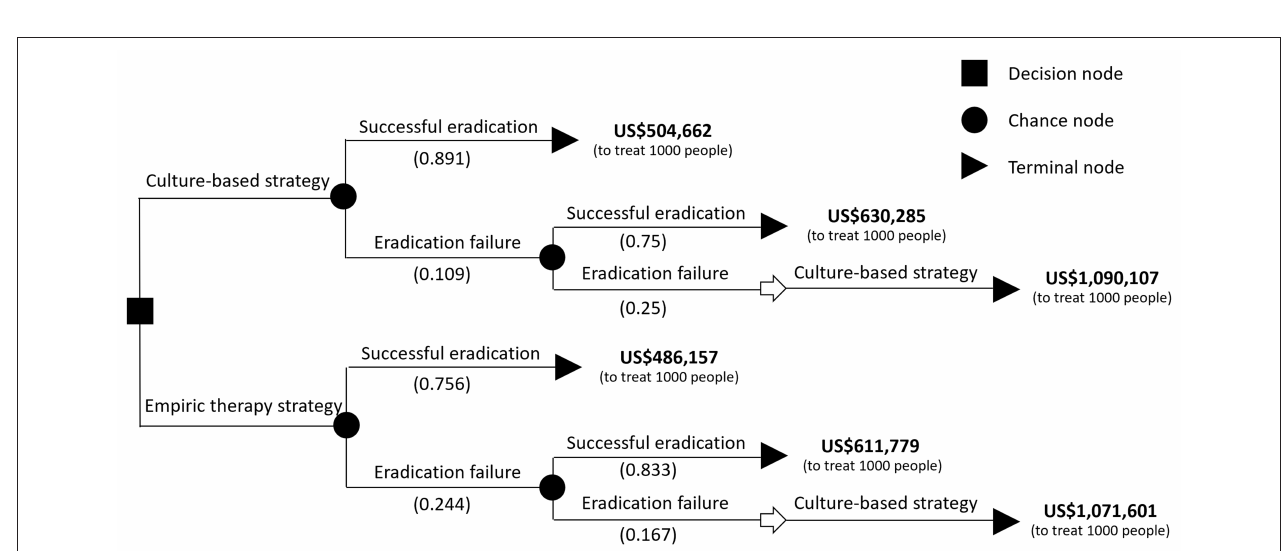
FIGURE 2 | The decision tree and eradication rate of the two eradication strategies. The probability of each outcome is noted beside the branches. The cost behind the terminal node was calculated in treating 1,000 infected children. The total cost of treating 1,000 infected children with a culture-based strategy was calculated as